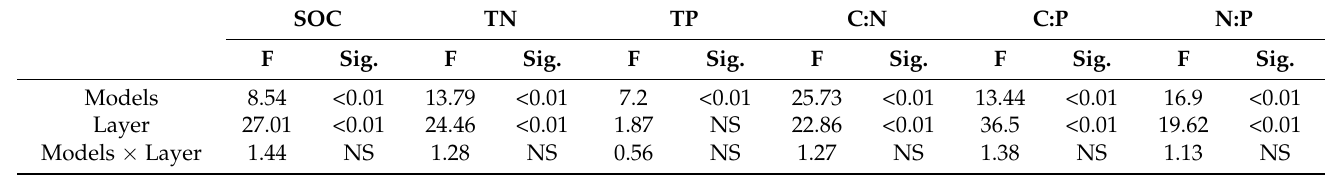
NS: not significant at p >